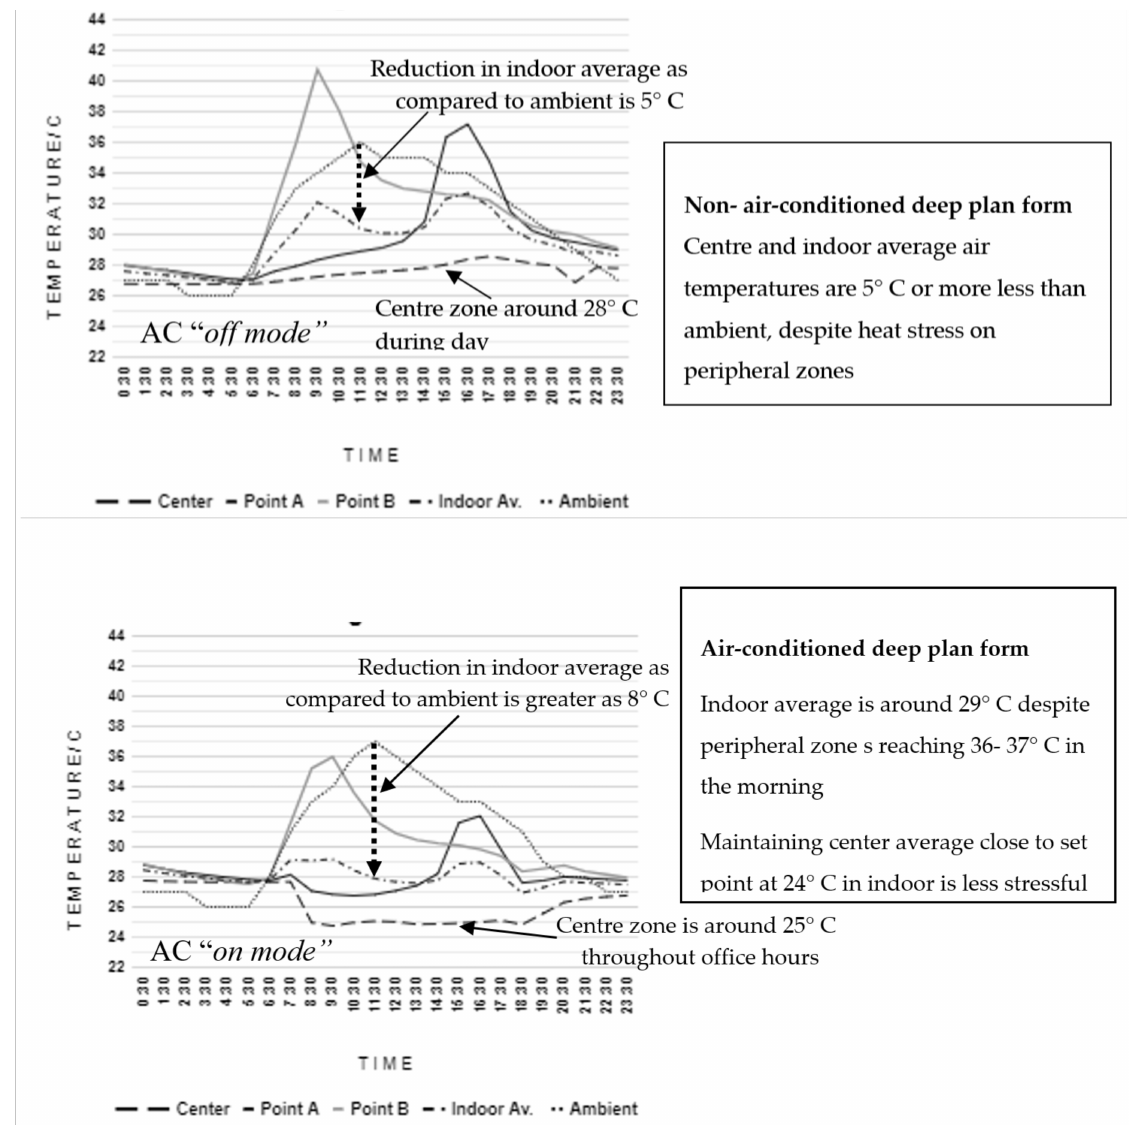
Figure 7. Top—12th floor of Building B in AC o ff -mode, Bottom—AC on-mode. Despite overheating in peripheral zones, center and average move closer to set point at 24 ◦